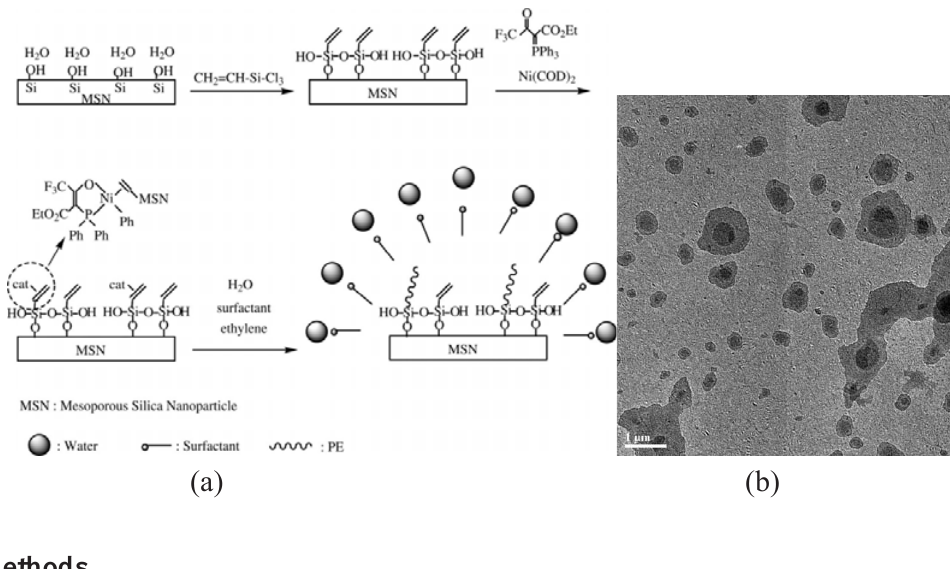
Figure 4. (a) The schematic illustration for emulsion polymerization of ethylene from MSN, (b) The TEM of the resulting PE/mesoporous silica composites. Reproduced with permission from [74]. Copyright 2009 John Wiley & Sons,